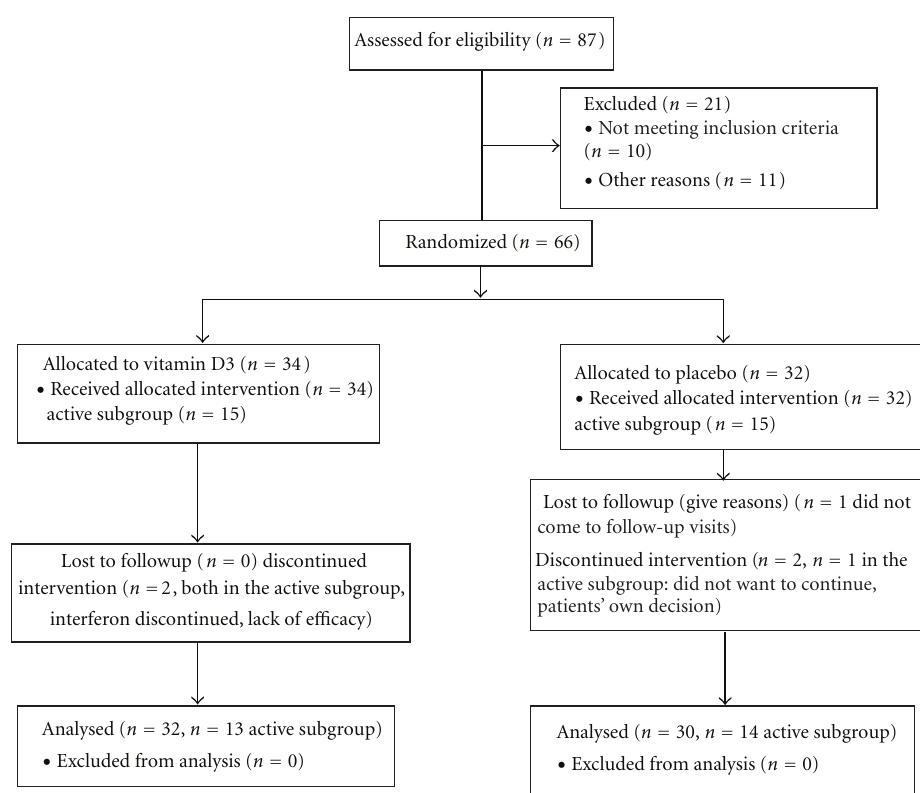
Figure 1: Study flow